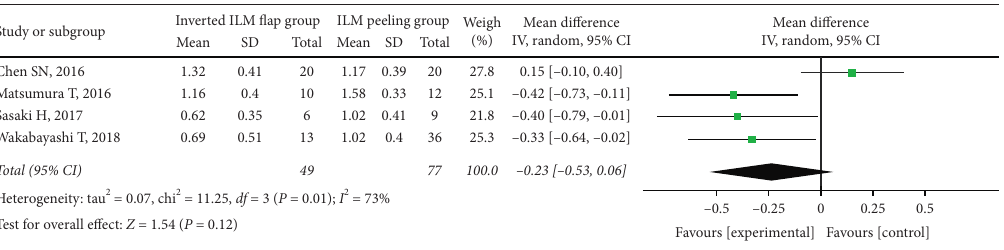
Figure 6: Forest plot comparing postoperative BCVA between inverted ILM flap and ILM peeling groups at 6 months after surgery. BCVA � best-corrected visual acuity, ILM � internal limiting